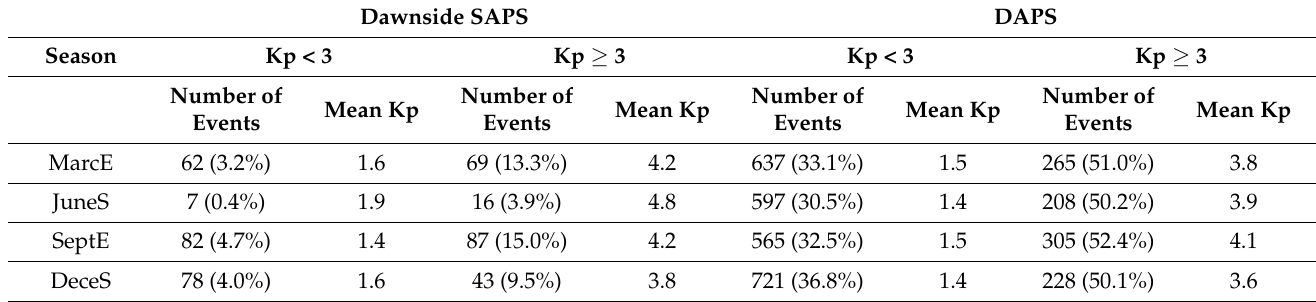
Table 1. The numbers of dawnside SAPS and DAPS events in each season under two different Kp levels. The abbreviation “MarcE” denotes the March equinox, “JuneS” denotes the June solstice, “SeptE” denotes the September equinox, and “DeceS” denotes the December